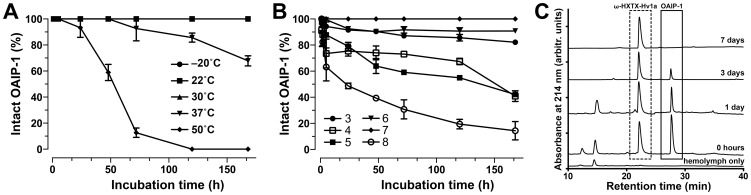
Stability of OAIP-1.(A) Thermal stability of sOAIP-1 over 7 days. Note that the data obtained at −20°C, 22°C, and 30°C overlap completely since OAIP-1 is 100% intact at these temperatures at all time points. OAIP-1 only degrades at temperatures of 37°C and higher. (B) Stability of sOAIP-1 over a range of different pH conditions. The toxin is least stable at alkaline pH. (C) A series of RP-HPLC chromatograms showing fractionation of undiluted hemolymph from H. armigera larvae (cotton bollworms) at various times following addition of 30 µg sOAIP-1 (highlighted in the solid box). Immediately before RP-HPLC fractionation, 30 µg of ω-HXTX-Hv1a (dashed box) was added to each sample for the purposes of quantification. In all experiments shown in panels A–C, intact OAIP-1 was identified using mass spectrometry.